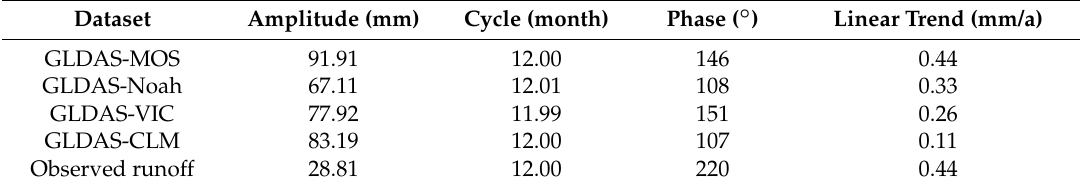
Table 2. The average ranking scores of runoff data from the four GLDAS models. Name